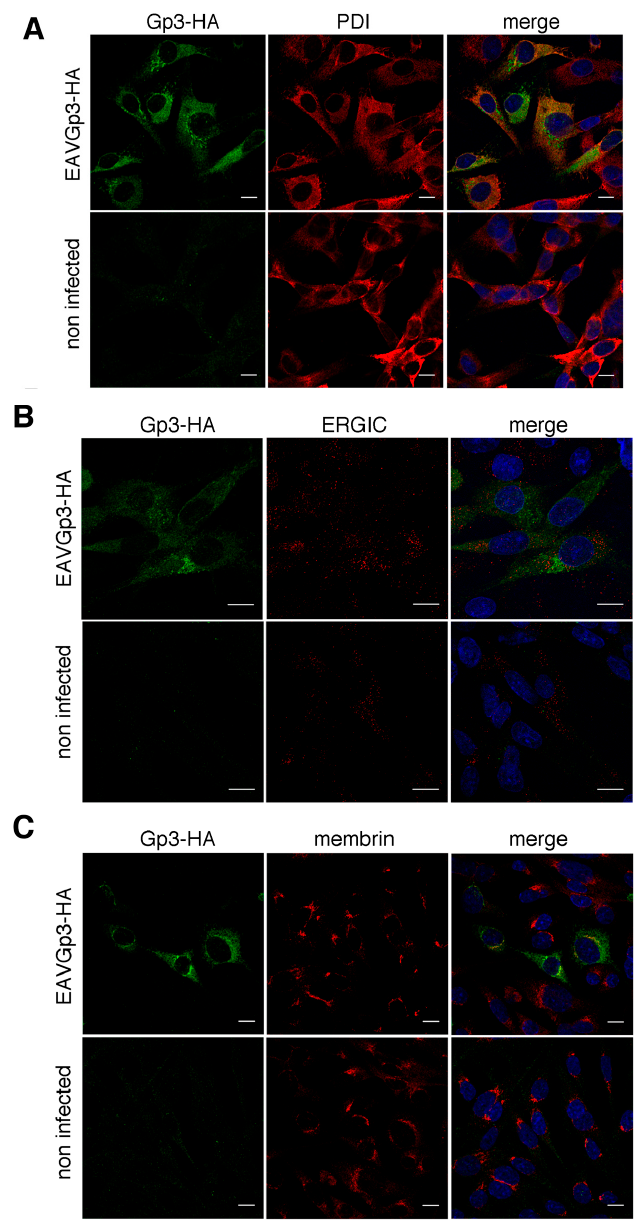
Figure 5. Co-localization of Gp3-HA with markers of the secretory pathway. The BHK-21 cells were infected with EAVGp3-HA at an MOI of 1 or left uninfected. Cells (18 h p.i.) were then subjected to immunofluorescence. Gp3-HA co-localized with PDI, marker for ER ( A ). Confocal analysis of the immunofluorescence samples stained with rabbit anti-HA antibodies and mouse anti-PDI antibodies and secondary Alexa Fluor 568-conjugated anti-mouse antibody and Alexa Fluor 488-conjugated anti-rabbit antibodies, respectively. Gp3-HA is shown in green, PDI is shown in red. Gp3-HA minimally co-localized with ERGIC ( B ). Confocal analysis of the immunofluorescence samples stained with rabbit anti-HA antibodies and mouse anti-ERGIC53 antibodies and secondary antibodies Alexa Fluor 568 anti-mouse and Alexa Fluor 488 anti-rabbit antibodies, respectively. Gp3-HA is shown in green, ERGIC is shown in red. Gp3-HA co-localizes with membrin, marker for cis-Golgi ( C ). Confocal analysis of the immunofluorescence samples stained with rabbit anti-HA antibodies and mouse anti-membrin antibodies and secondary Alexa Fluor 568-conjugated anti-mouse antibody and Alexa Fluor 488-conjugated anti-rabbit antibodies, respectively. Gp3-HA is shown in green, membrin is shown in red. The cell nuclei were stained with DAPI. Scale bar = 10 µ